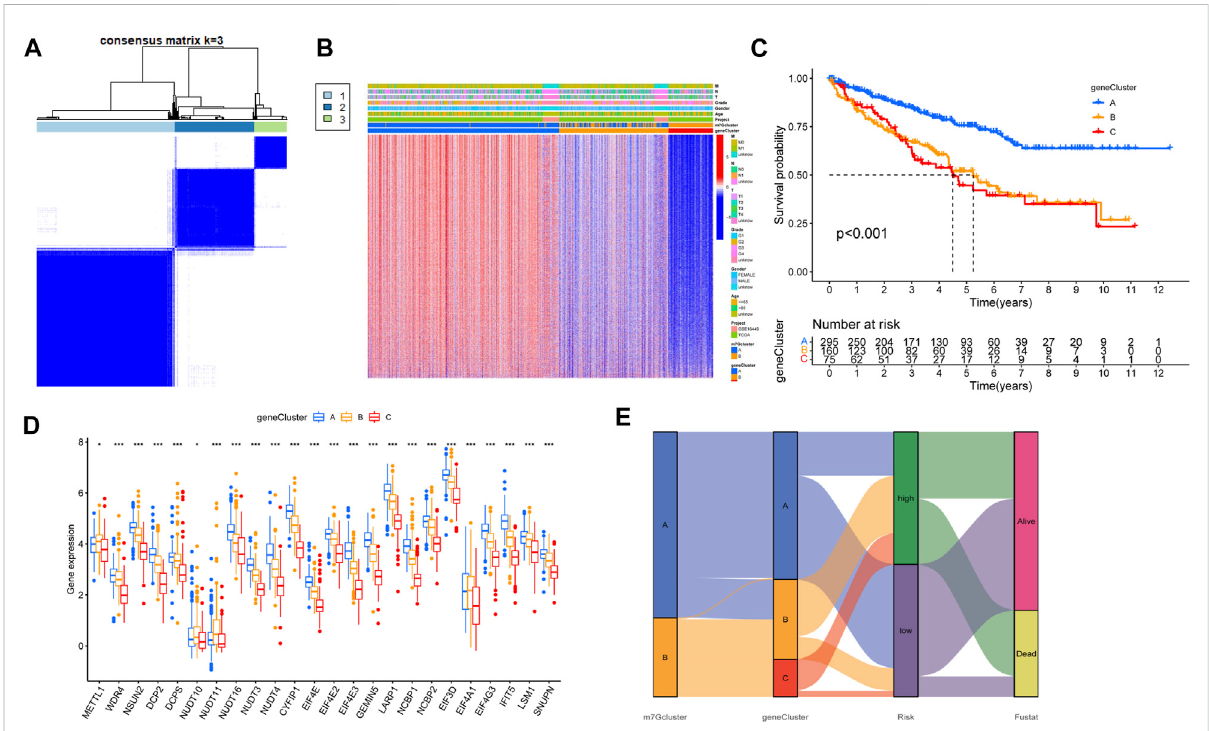
Characteristics of prognosis-related gene subtypes. (A) Prognosis-related genes were divided into three subtypes. (B) Survival analysis of prognosis-related gene subtypes. (C) The expression of prognosis-related gene subtypes and the clinical characteristics of the subtypes. (D) Correlationsbetween prognosis-related genesubtypes and m7G-related genes. (E) The Sankeydiagram inthe process ofconstructing aprognostic model. * p < 0.05, ** p < 0.01, *** p <